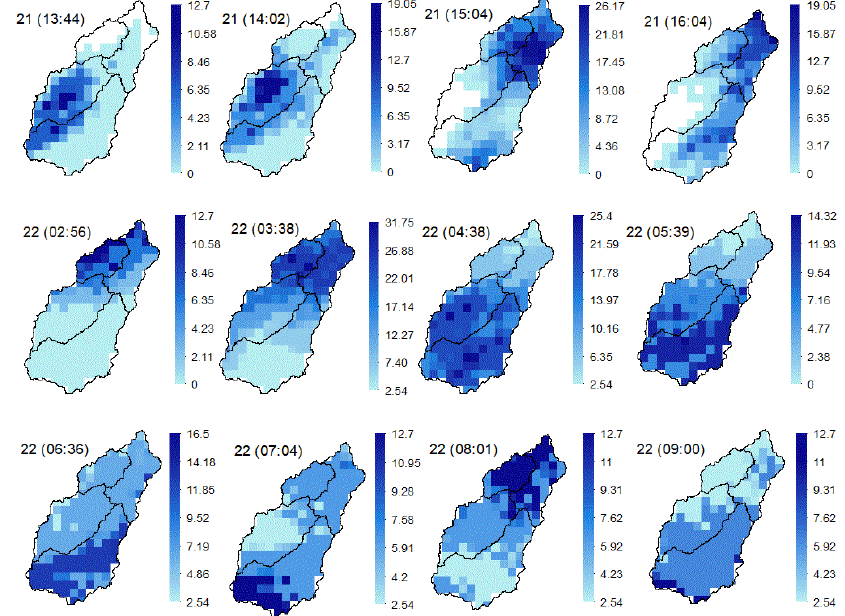
Figure 3. Spatially distributed cumulative precipitation (mm) of selected available one-hour NEXRAD Level III images (4 km) for the August 2017 flood event in the UTC time zone after processing.